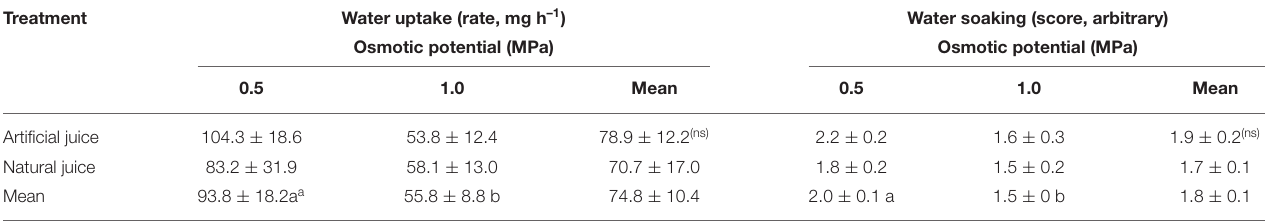
Artificial juice